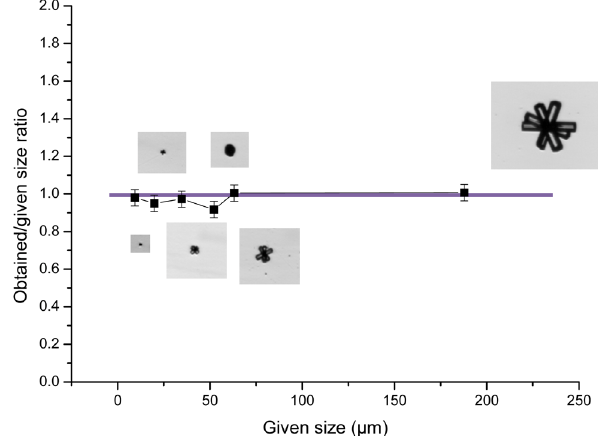
Fig. 5. The calculated particle diameter (of a water droplet) versus Figure 5. The calculated particle diameter (of a water droplet) versus the displacement from 3 the displacement from the focal plane of the imaging system used the focal plane of the imaging system used in PHIPS (black solid squares), the slope of the 4 in PHIPS (black solid squares), the slope of the gray scale variation gray scale variation at inflection point around the particle edge (blue solid triangles), and its 5 at inflection point around the particle edge (blue solid triangles), Gaussian fit (red line). The vertical dashed lines at d- and d+ show the former limits given by 6 and its Gaussian fit (red line). The vertical dashed lines at d- and Schön et al. (2011) of the DOF obtained before using the pulsed incoherent illumination laser 7 d+ show the former limits given by Sch¨on et al. (2011) of the DOF and the inflection point edge detection algorithm. 8 obtained before using the pulsed incoherent illumination laser and the inflection point edge detection algorithm.